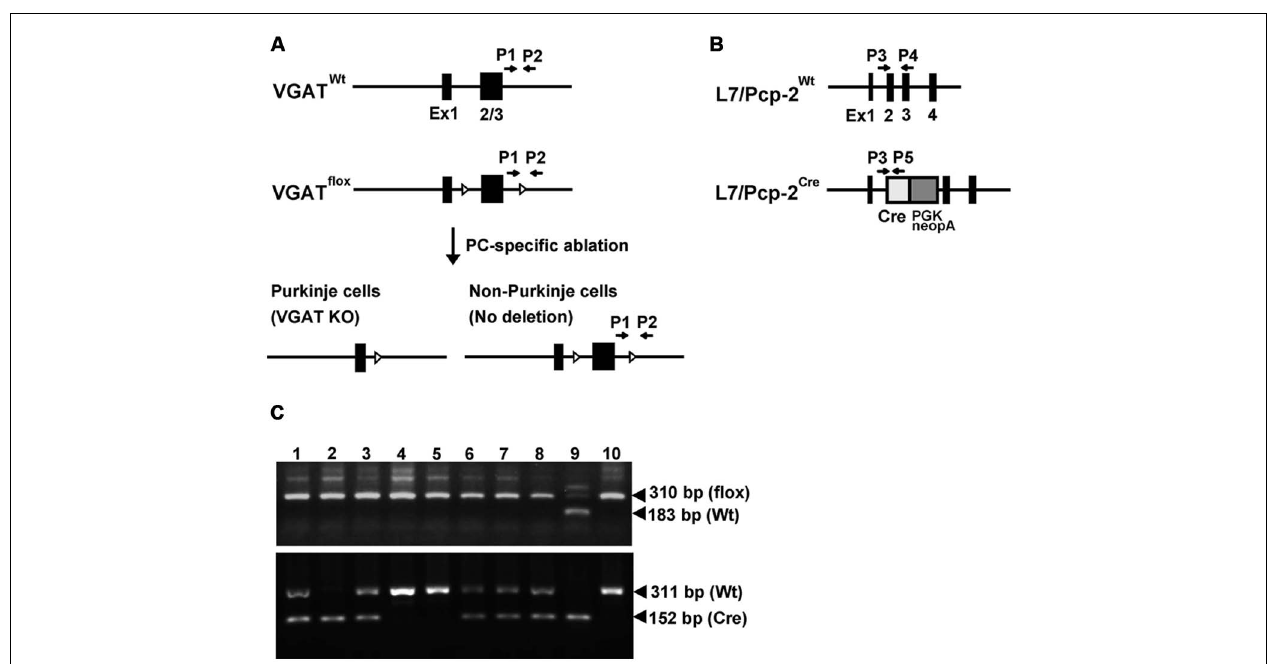
FIGURE 1 | L7/Pcp-2 promoter-mediated disruption of the VGAT gene. (A) Schema of the wild-type and floxed VGAT allele (upper). Black boxes and white triangles indicate exons and loxP sites in the VGAT gene, respectively. Black arrows indicate the primer sites for PCR genotyping. Schema of cerebellar Purkinje cell (PC)-specific VGAT gene disruption in L7-VGAT mice (lower). (B) Schema of the wild-type and Cre knock-in L7/Pcp-2 ( L7 ) allele. Black boxes indicate exons in the L7 gene. White and gray boxes indicate the Cre gene and the PGK-Neo cassette, respectively, that were introduced into exon 2 of the L7 gene. The black arrows indicate